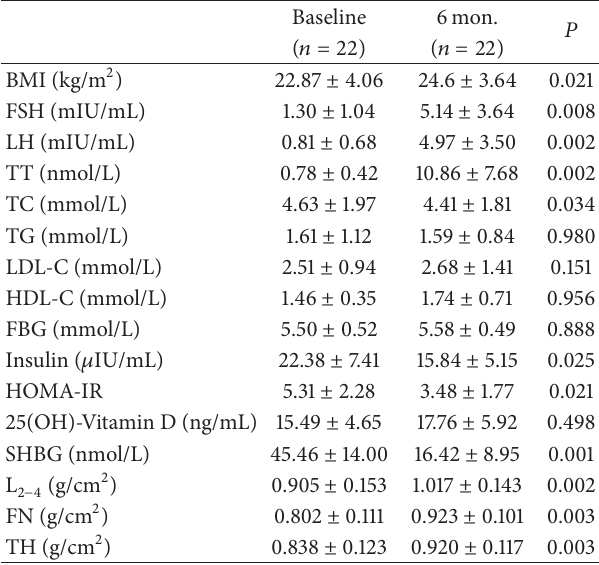
Table 2: Changes of biochemical, hormonal, and densitometric parameters in patients after 6 months of pulsatile gonadorelin